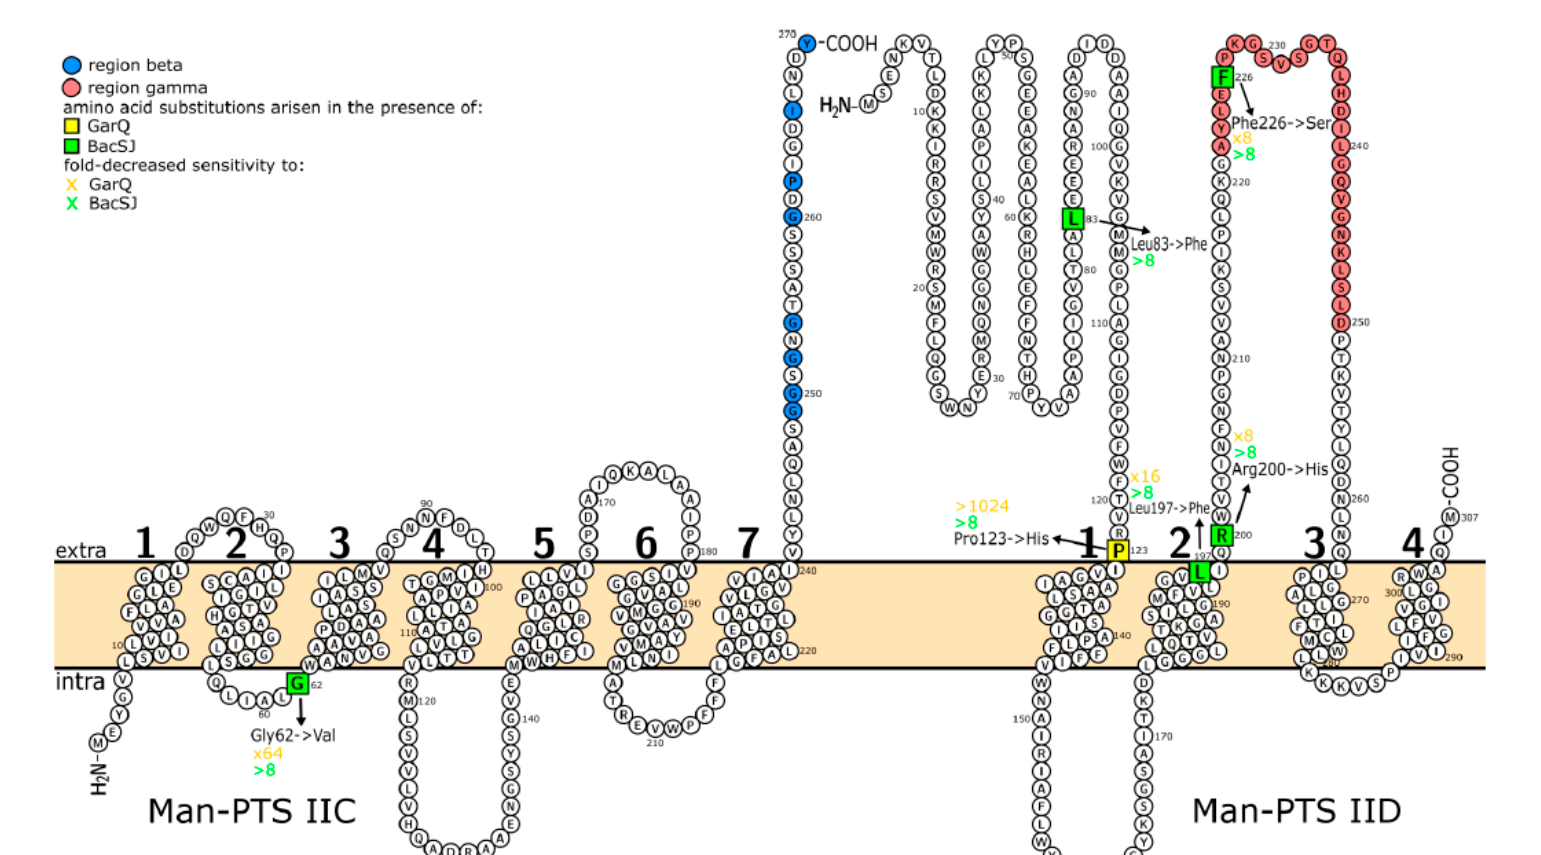
Figure 4. Predicted membrane topology of L. lactis IL1403 Man-PTS subunits IIC and IID. Amino acids substituted in spontaneous bacteriocin-resistant mutants are marked with squares. Numbers indicate successive transmembrane regions.